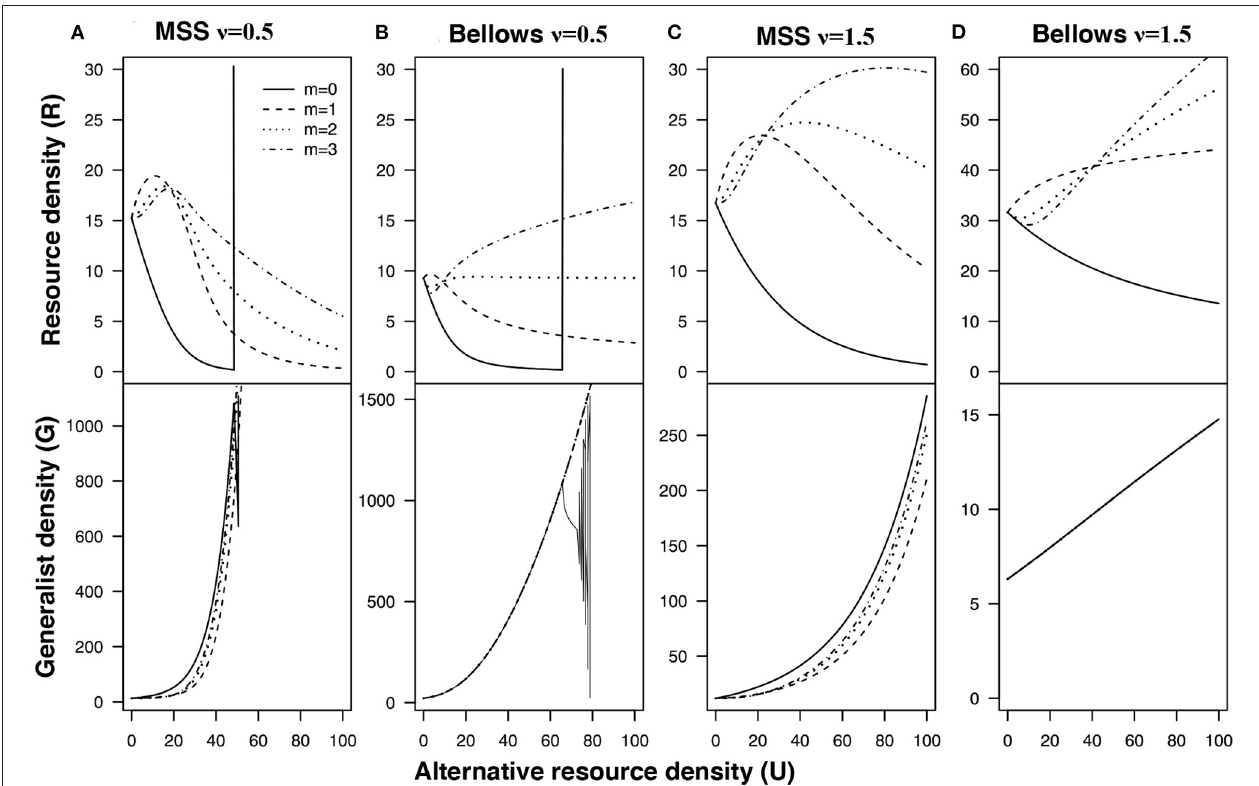
ln (1 ( η G ) ν ): = + 0; Dashed m 1; = =